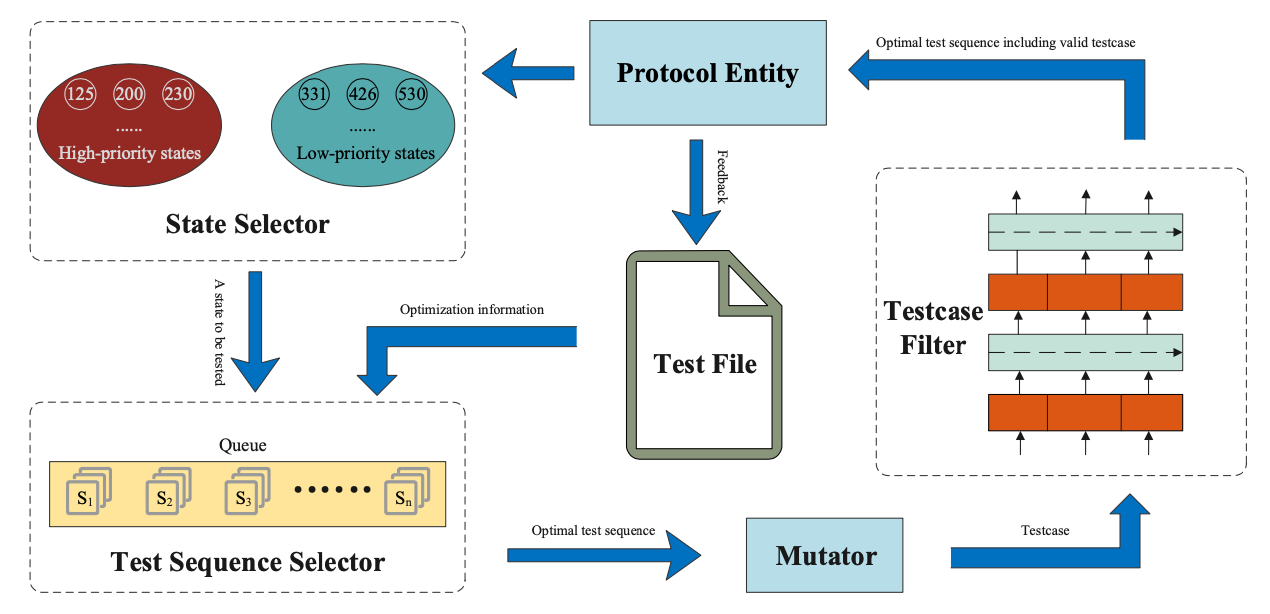
Figure 1. The structure of